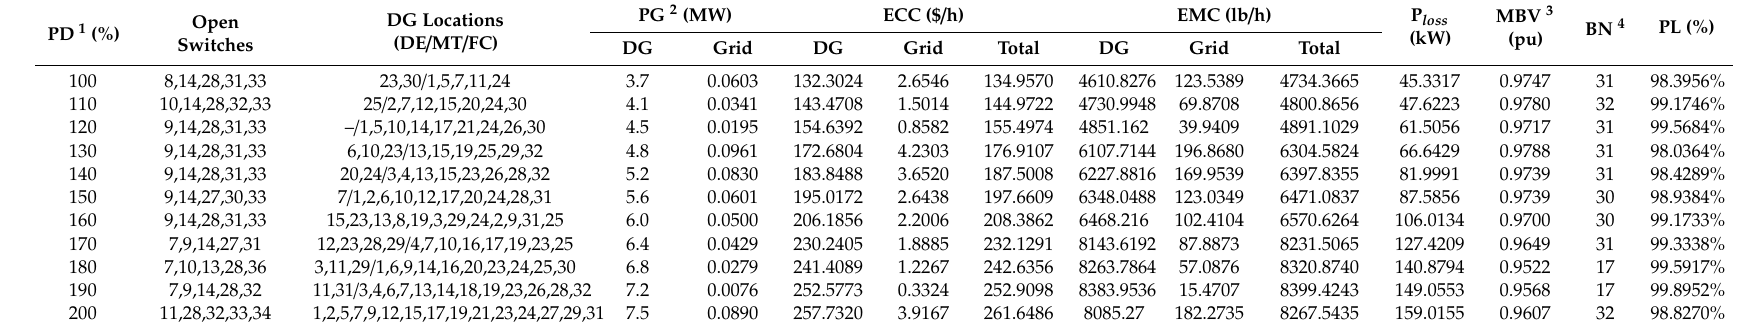
Table 13. Scenario 3: system reconfiguration results of auto-select DG combination under maximum DG quantity and increasing power